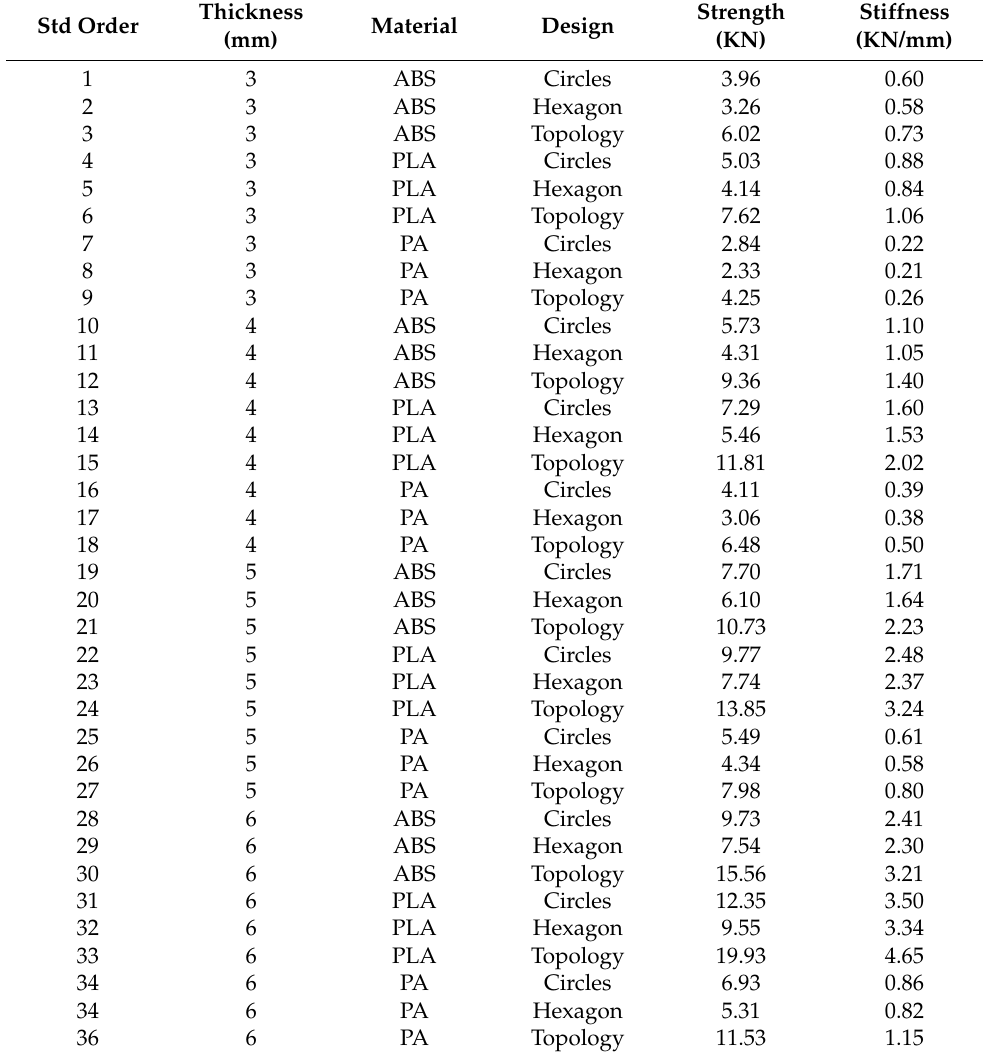
Table 4. Design of experiment matrix with the corresponding strength and